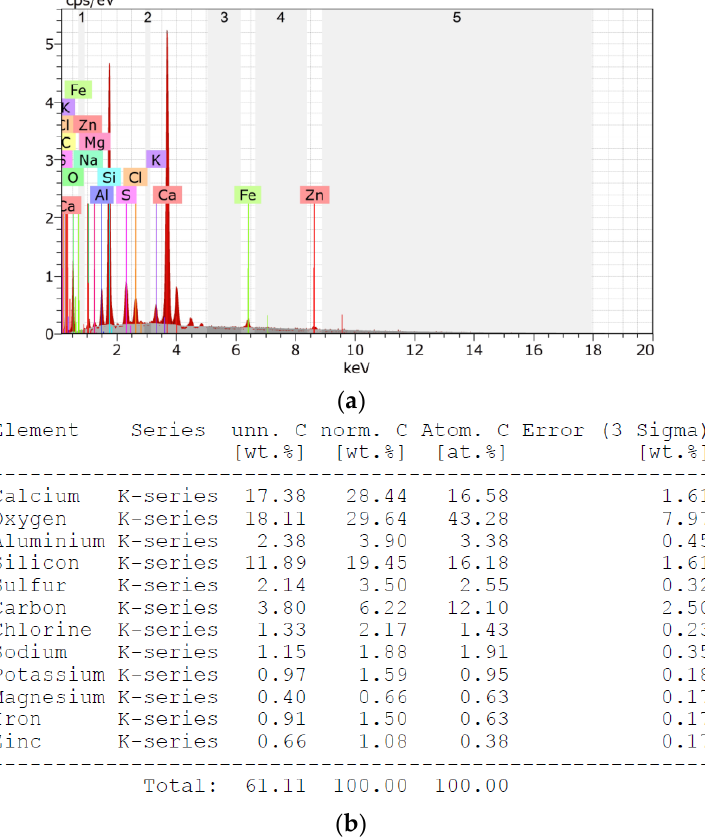
Figure 4. Results of EDS procedure of slag ( a ) with elemental composition ( b ). Table 4. Chemical composition of MSWI slag.